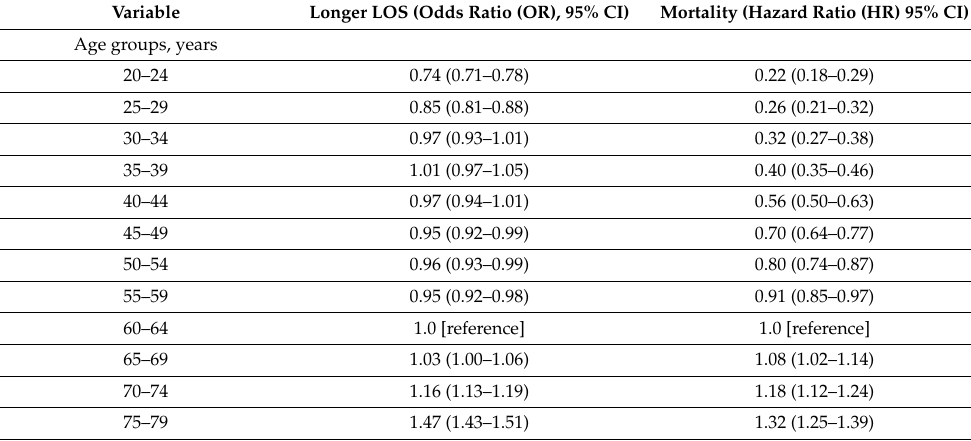
Figure 2. Boxplots showing median and inter-quartile length of hospital stay according to specialty services for patients hospitalized over two years in Victoria, Australia. Specialties are ranked according to increasing median length of stay. The risk categories were as follows. 1 (Diagnostic GI endoscopy-obstetrics); 2 (Clinical Cardiology-Drug & alcohol); 3 (Endocrinology-immunology & infections); 4 (Renal Medicine-Tracheostomy). Table 3. Associations with prolonged hospitalization ( ≥ 14 days) and in-hospital mortality for patients hospitalized over two years in Victoria, Australia.